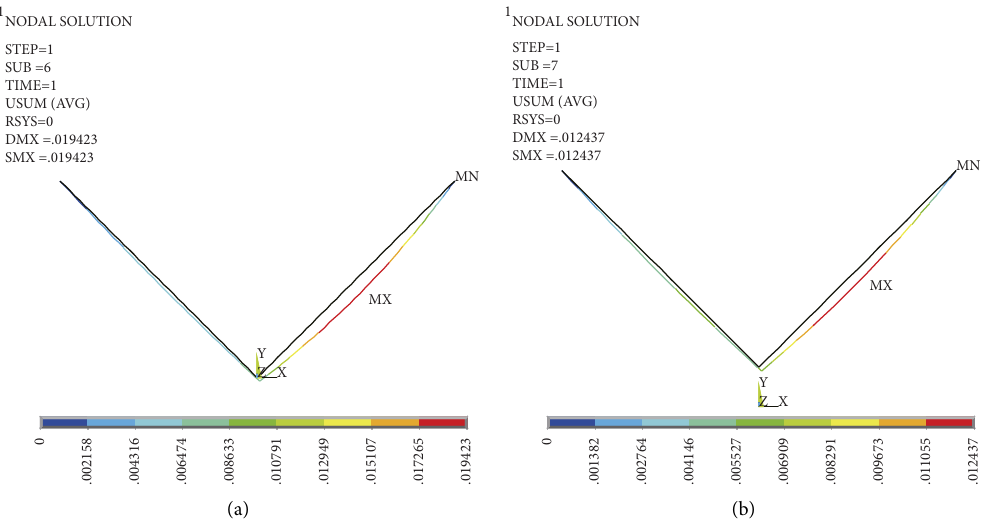
Figure 11: (a) Te deformation of the V -type insulator string with wind speed 20m/s. (b) Te deformation of the Y -type insulator string with wind speed